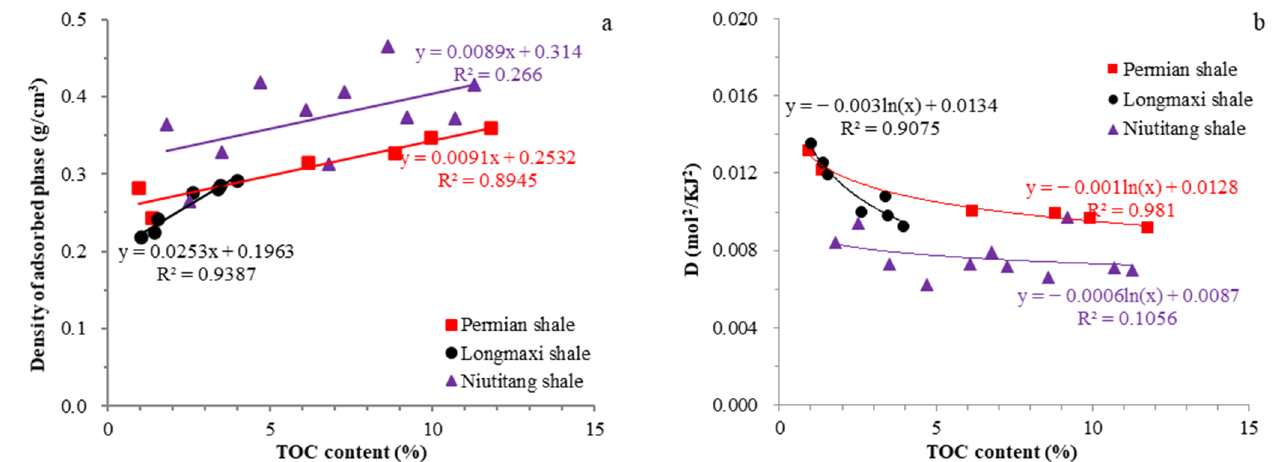
Figure 5. Plots showing the relationships between the density of the adsorbed phase with the TOC content ( a ) and the pore structure parameter D with the TOC content ( b ). (The Longmaxi and Niutitang shales are from Pan et al. [8] and Li et al. [14], respectively). Gas adsorption is closely related to the pore structure of the adsorbent. The volume filling is mainly forming of methane adsorption in micropores (pore size < 2 nm); thus, the adsorbed amount depends on the volume of micropores. Monolayer–multilayer adsorption occurs on the surface of mesopores (2–50 nm) and macropores (>50 nm), and the adsorbed amount is related to the specific surface area [60]. Furthermore, the relationships between adsorption parameters and pore structure parameters of those shales are compared. The maximum excess and absolute adsorbed amounts of Permian shales have a strong linear positive correlation with the BET surface area and micropore volume (Figure 6; Table 3). The correlation with micropore volume is stronger than the correlation with surface area, because the adsorption capacities of micropores are stronger than larger pores [17,61]. Therefore, micropores in shales are the most important carriers for provid- ing sites for methane adsorption, and the surface adsorption of mesopores and macropores is auxiliary [32,61,62]. The Permian shales show relatively smaller adsorption than the Longmaxi and Niutitang shales with the same micropore volume and BET sur- face area, indicating that the pore structure of shales with type III kerogen have lower methane adsorption capacities than marine shales with type I and/or type II kerogen.